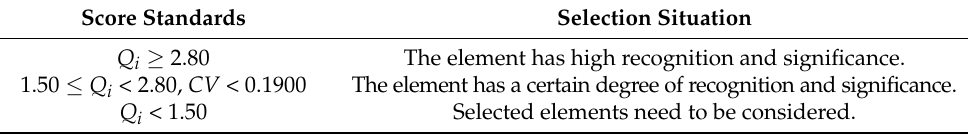
Table 2. Selection principles